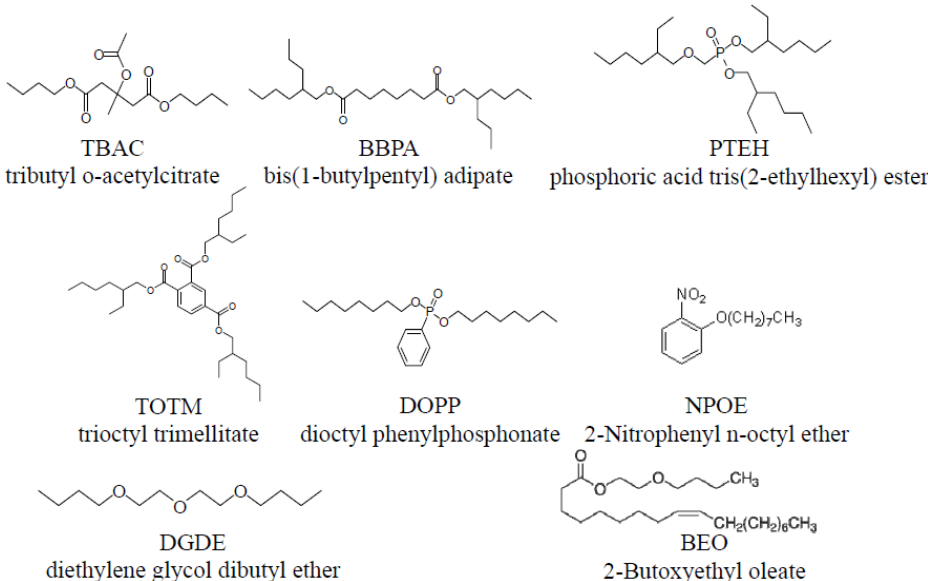
Figure 5. Plasticizers: eight plasticizers were used in this study.